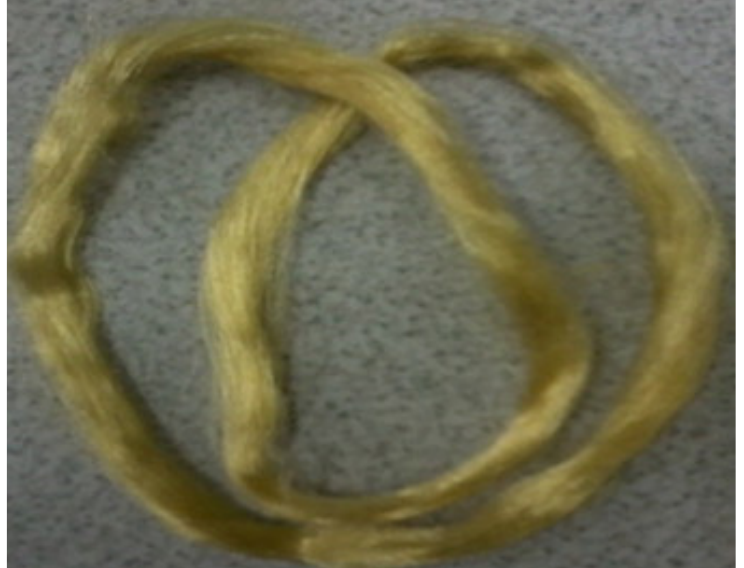
Figure 12. The photograph of the cellulose–chitosan composite fibres made by [152] using a binary ionic liquid system and the dry-wet spinning procedure. Reprinted from Carbohydrate Polymers , 88/1, Ma, Bomou, Zhang, Meng, He, Chunju, Sun, Junfen, New binary ionic liquid system for the preparation of chitosan/cellulose composite fibers, 347–351, Copyright (2012), with permission from Elsevier.